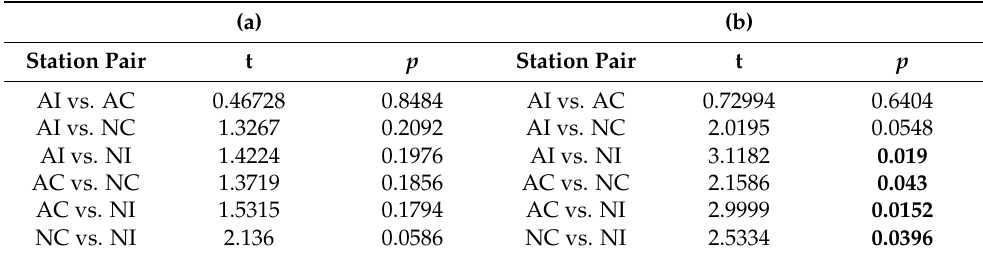
Table 3. Pair-wise comparisons and t-statistics for differences in rare meiobenthic assemblages among stations within levels of the depth factor. Significant tests relevant to the hypothesis are given in bold. ( a ) Within level ‘20’ of factor ‘Depth’. ( b ) Within level ‘50’ of factor ‘Depth’.